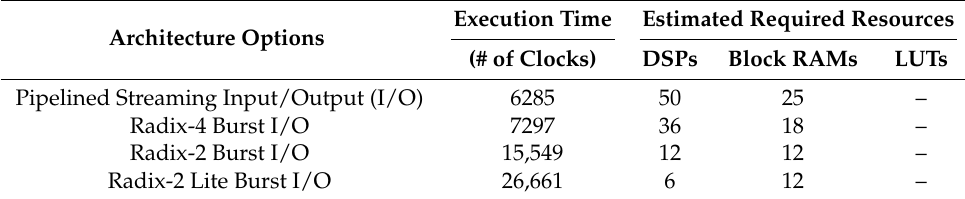
Figure A2. Algorithm description of the FFT_FSM subsystem, which includes the windowing and the power spectrum procedures. Table A1. Architecture options available using the Fast Fourier Transform v9.0 provided by Xilinx, its execution time and required resources for full-precision unscaled